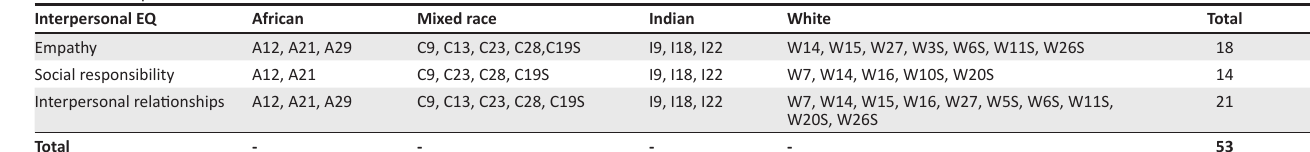
TABLE 7: Interpersonal EQ. Interpersonal